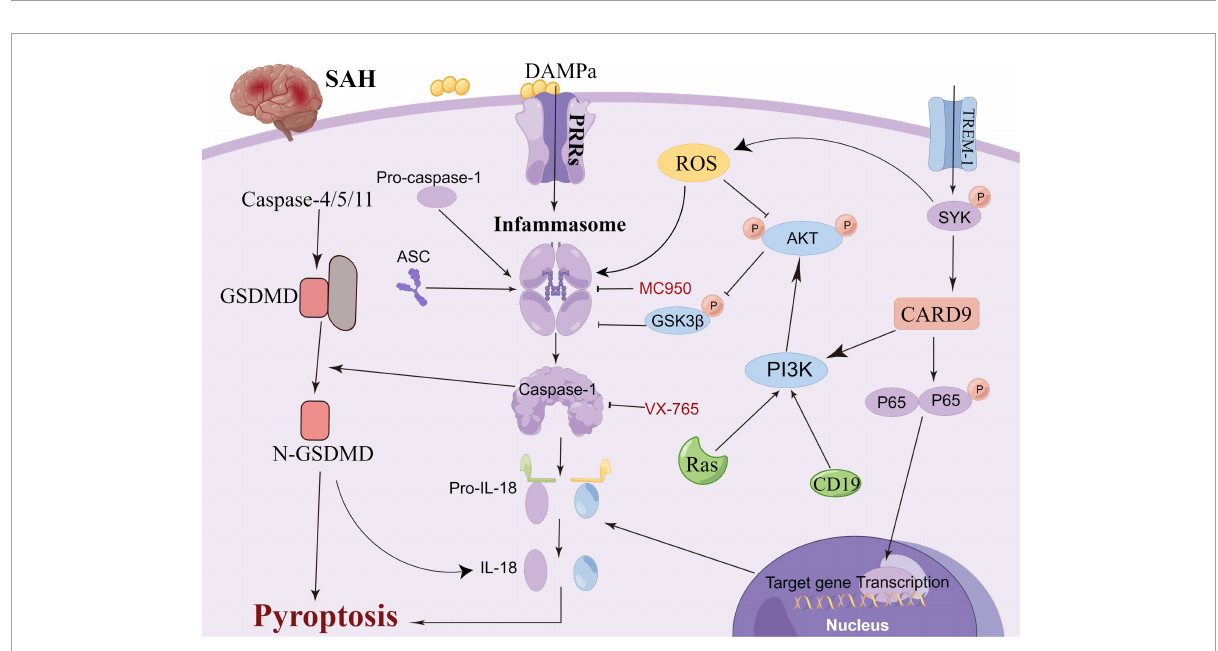
FIGURE3 Molecular mechanisms of pyroptosis from subarachnoid hemorrhage to early brain injury (EBI).